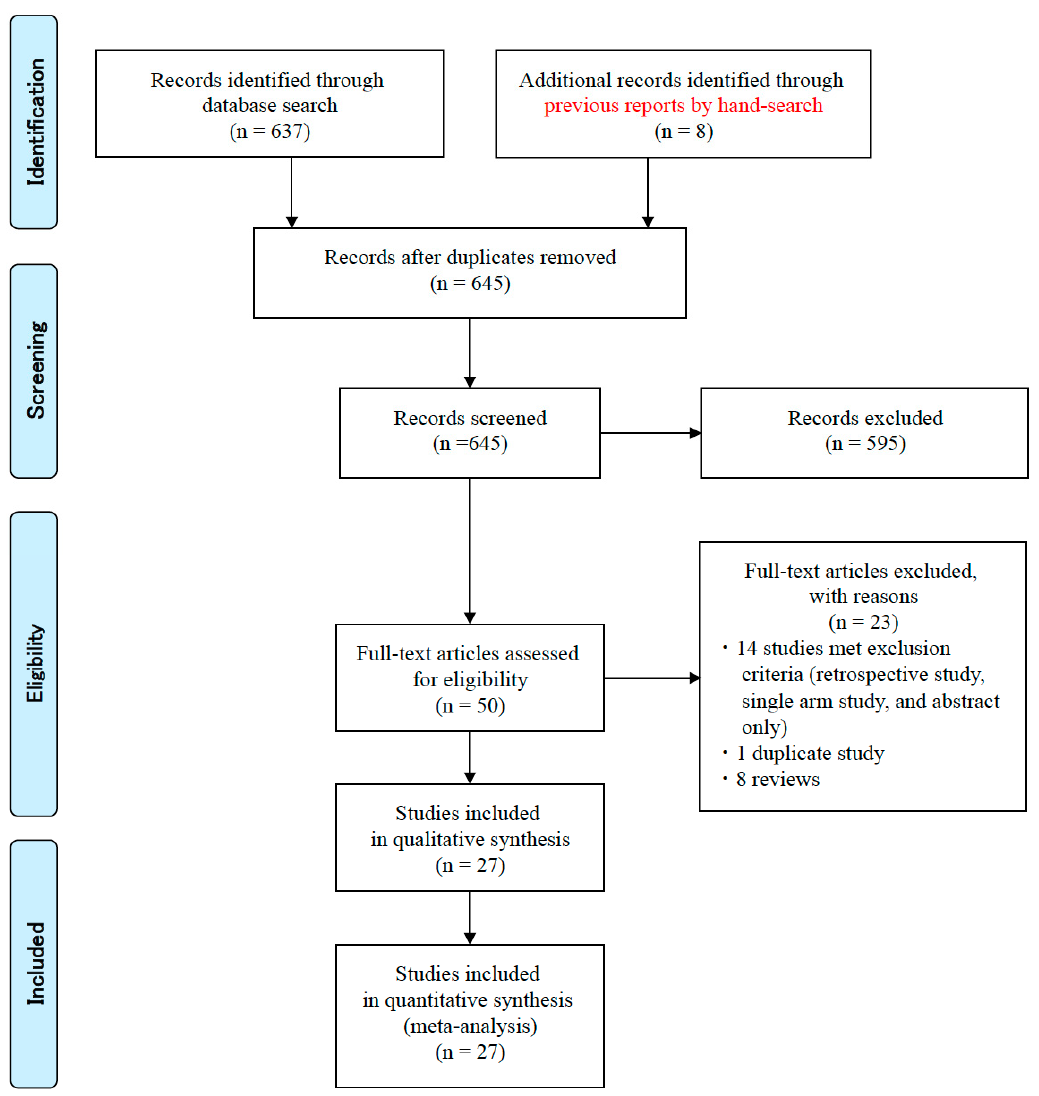
Figure 1. Workflow for the selection of studies comparing incidence rates of endoscopic reflux esophagitis and reflux-related symptoms.